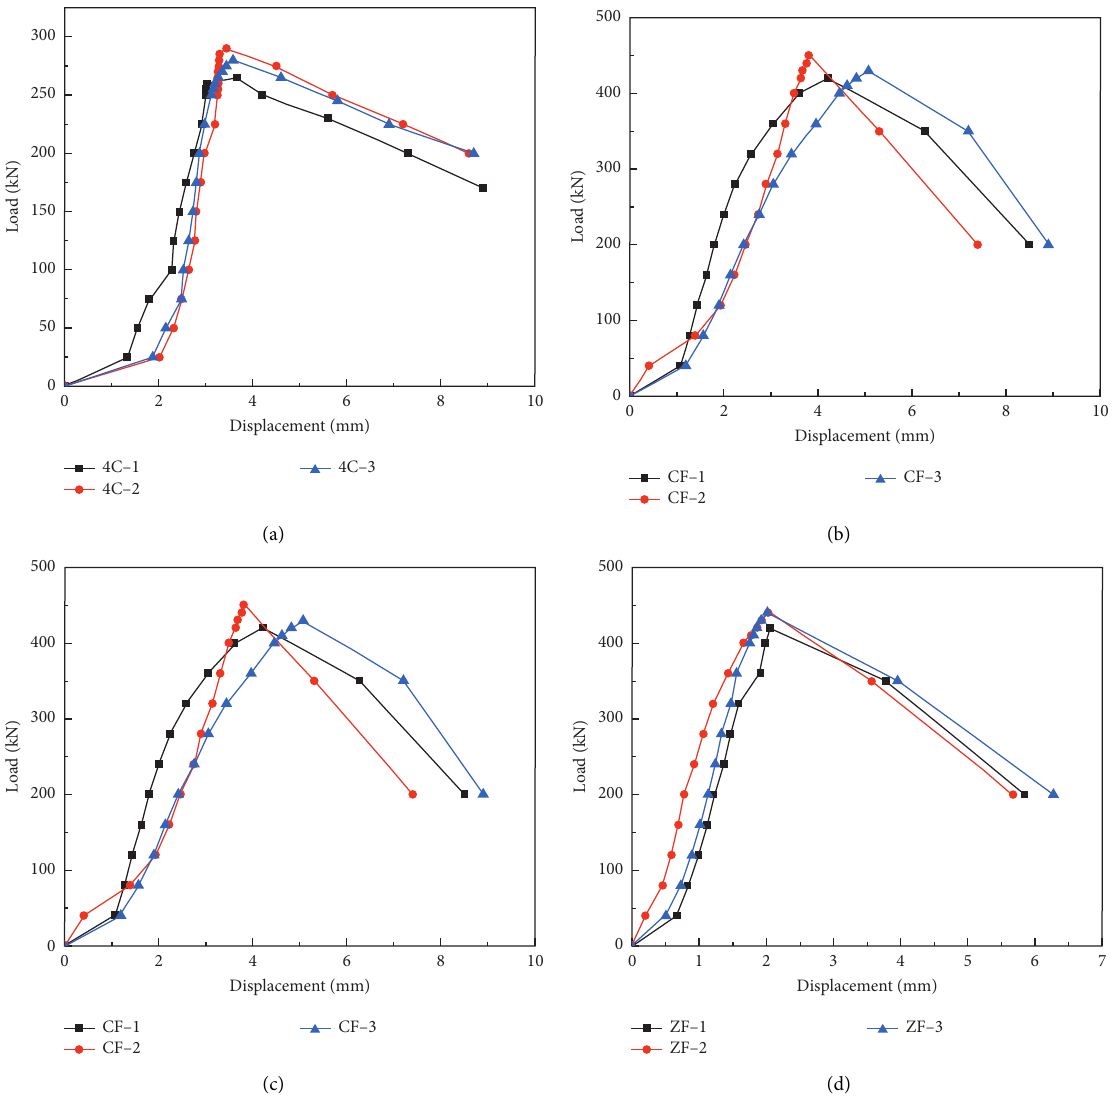
Figure 26: Load-axial displacement curve: (a) 4C-type load-displacement curves, (b) CU-type load-displacement curves, (c) CF-type load- displacement curves, and (d) ZF-type load-displacement